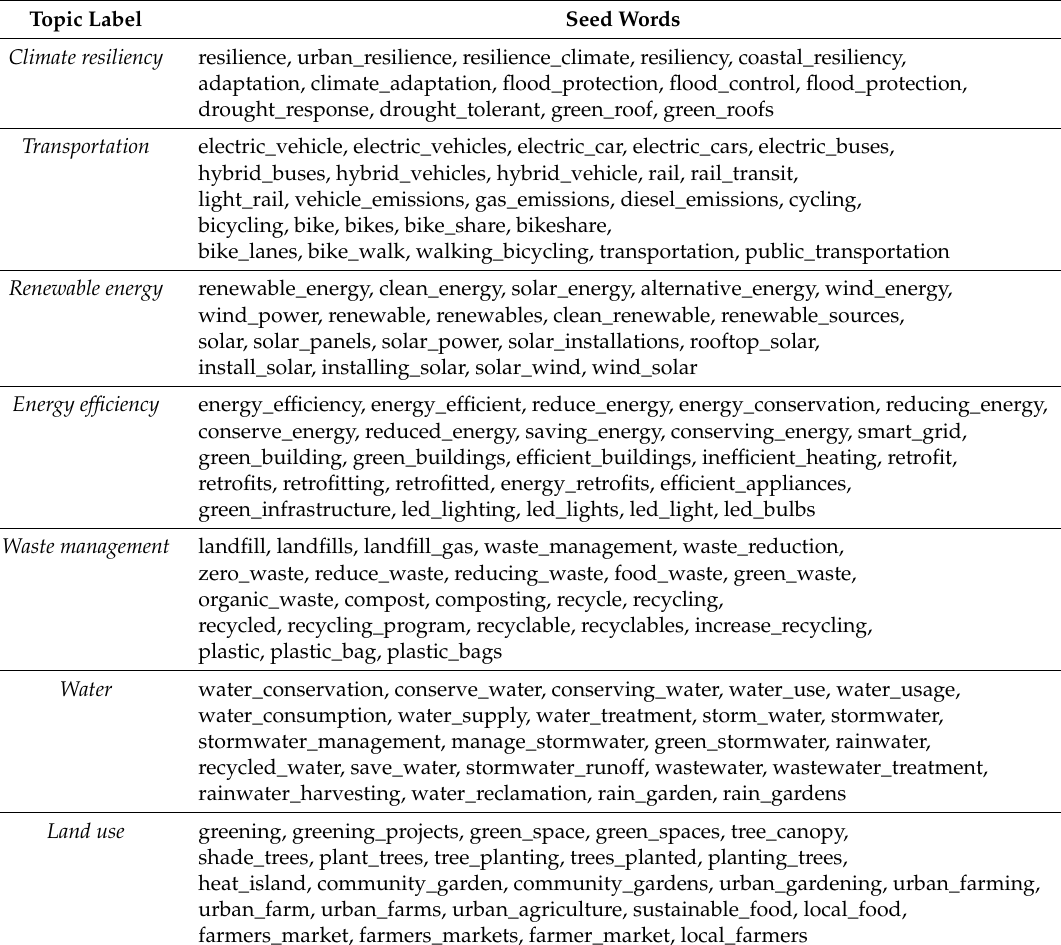
Table A1. List of seeded keywords for each